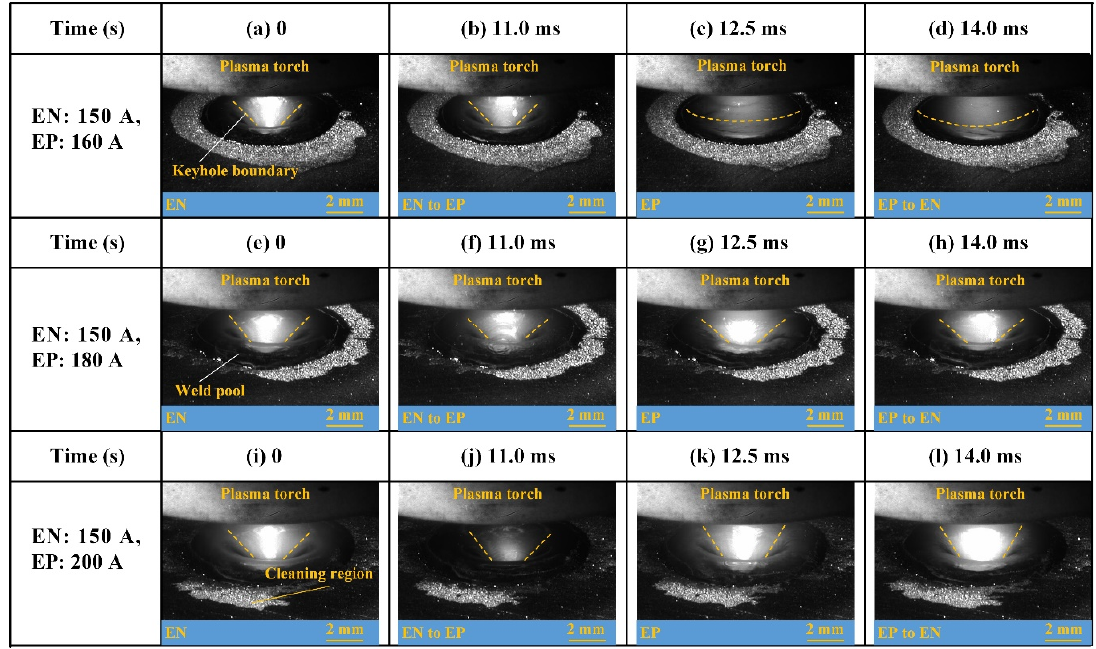
Figure 18. The evolution of weld pool upside surface in one cycle with different EP current: ( a – d ) EP = 160 A; ( e – h ) EP = 180 A; ( i – l ) EP = 200 A.